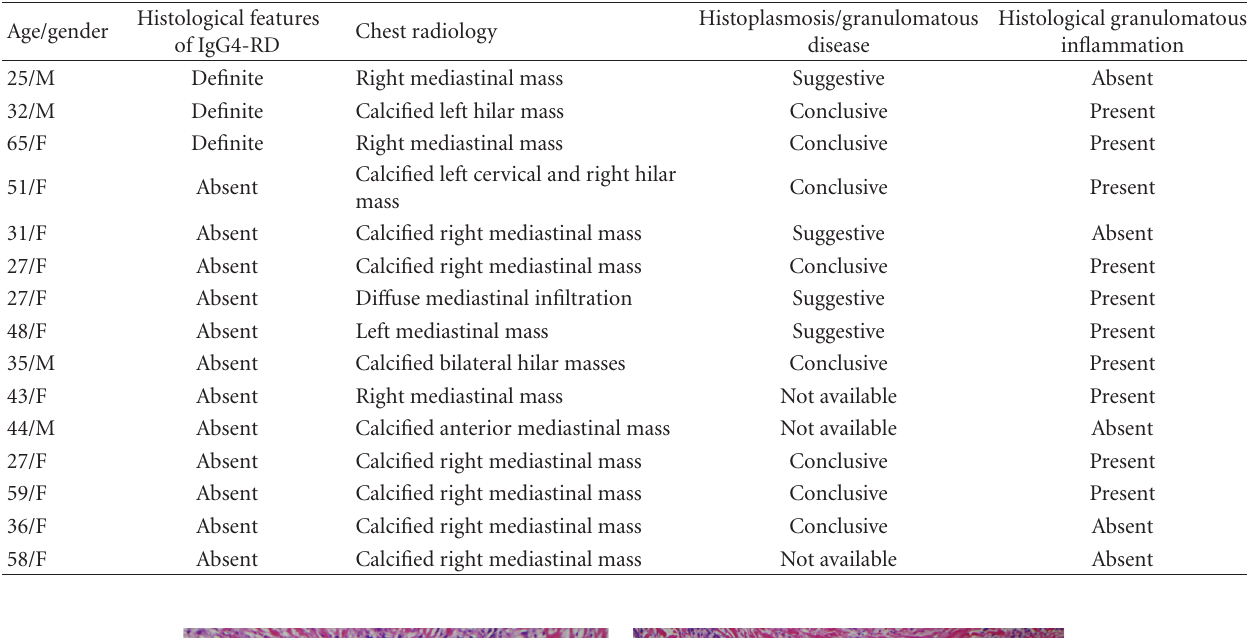
Table 1: Radiological, microbiological and histological characteristics of the 15FM patients.